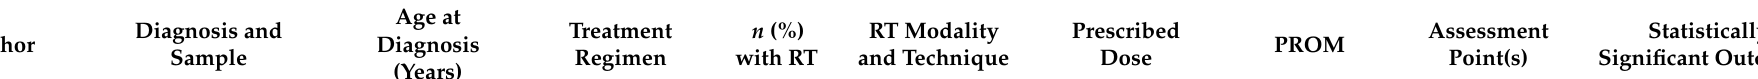
Table 4. Health-related quality of life in cohorts including multiple diagnoses or radiation therapy